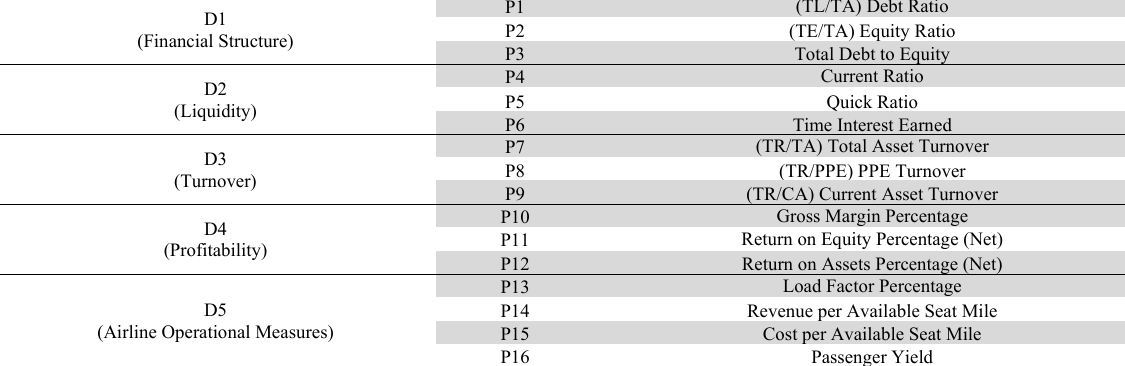
Airline financial and operational criteria and